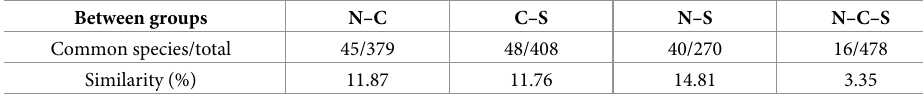
Table 4. Similarity of species composition among areas.